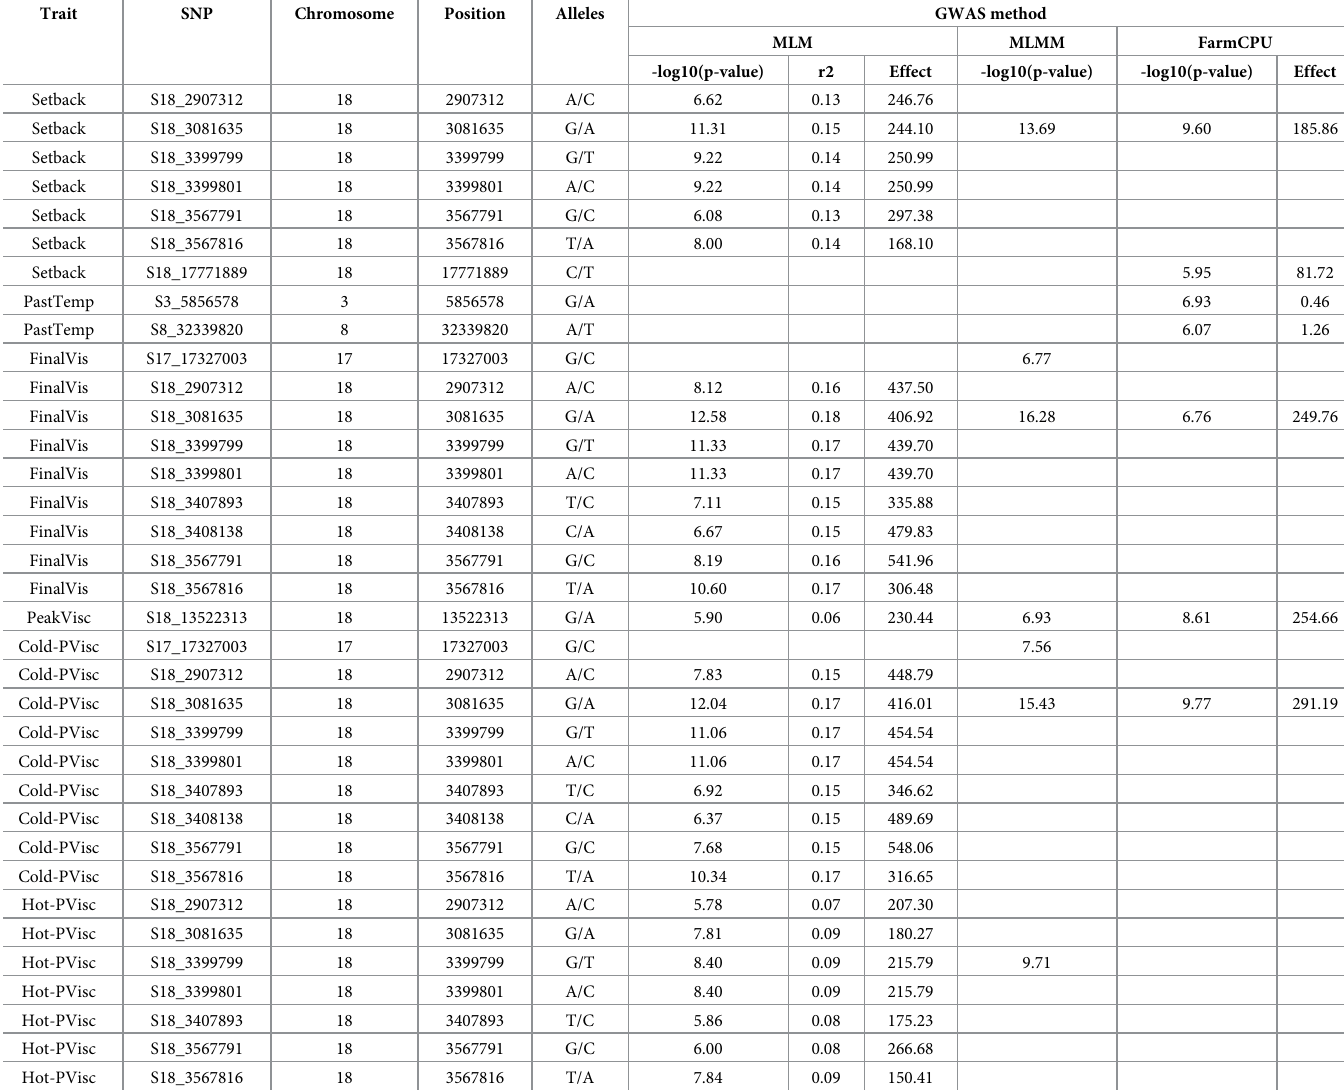
Table 2. Single-nucleotide polymorphism (SNP) markers associated with cassava starch pasting properties based on the MLM, MLMM, and FarmCPU